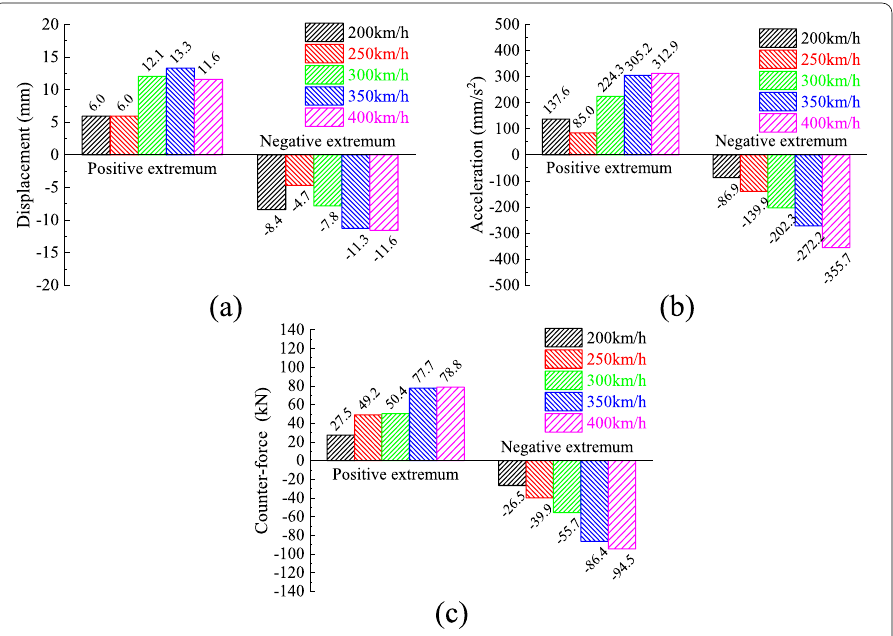
Fig. 14 Girder dynamic response at different train speeds in construction stage: a maximum displacement value; b maximum acceleration value; c maximum counter-force of the temporary